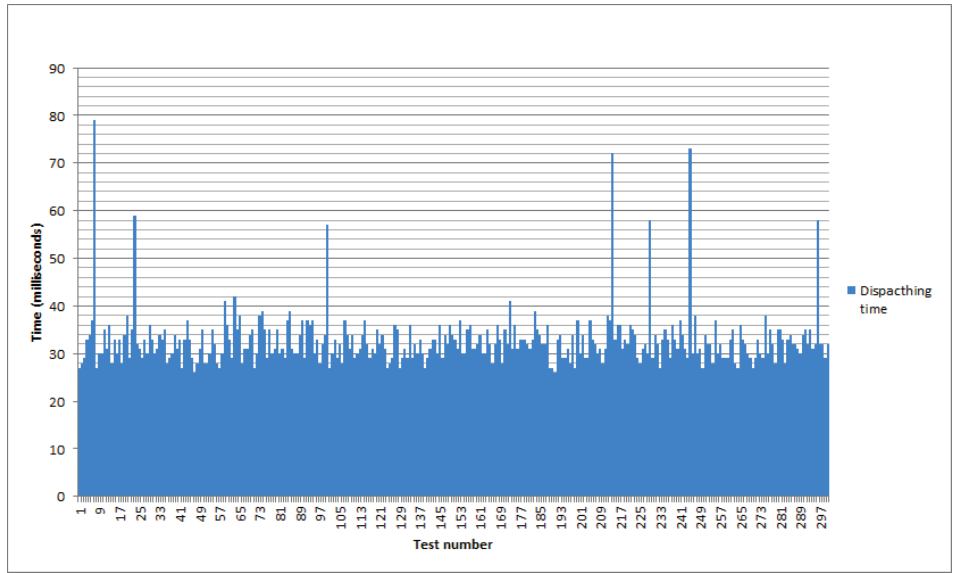
Figure 9. Time to dispatch an event from the